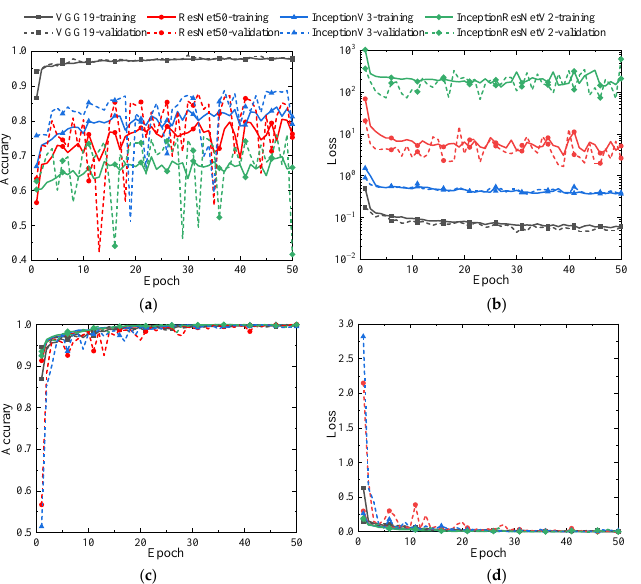
Figure 6. Detailed training process for deep neural networks. ( a ) Training and validation accuracies (frozen); ( b ) training and validation losses (frozen); ( c ) training and validation accuracies (unfrozen); ( d ) training and validation losses (unfrozen).